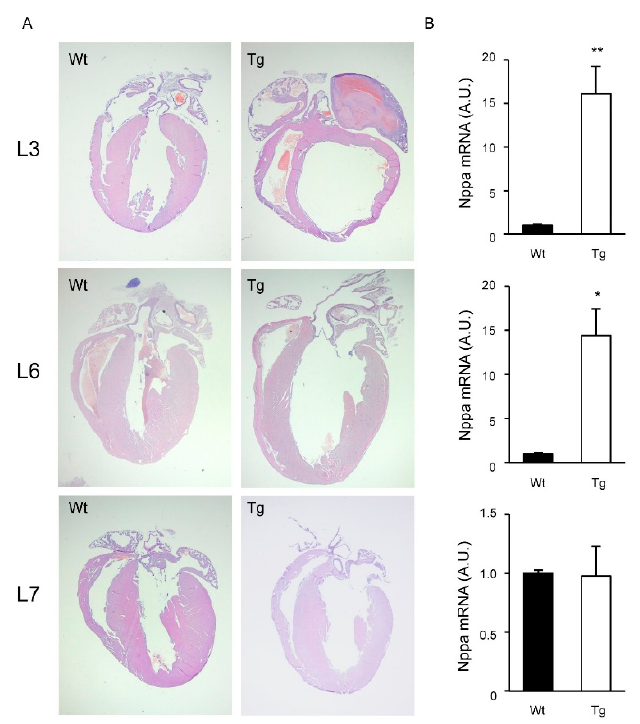
Figure 4. Morphological abnormalities in hearts of hERR γ -Tg mice. ( A ) Histological sections of hERR γ -Tg mouse lines L3, L6, and L7 stained with hematoxilin/eosin. ( B ) mRNA expression of Nppa was determined by real-time quantitative PCR in cardiac tissue from hERR γ -Tg mice. Data are mean ± SEM of 3–4 animals/group; * p = 0.05; ** p = 0.01.